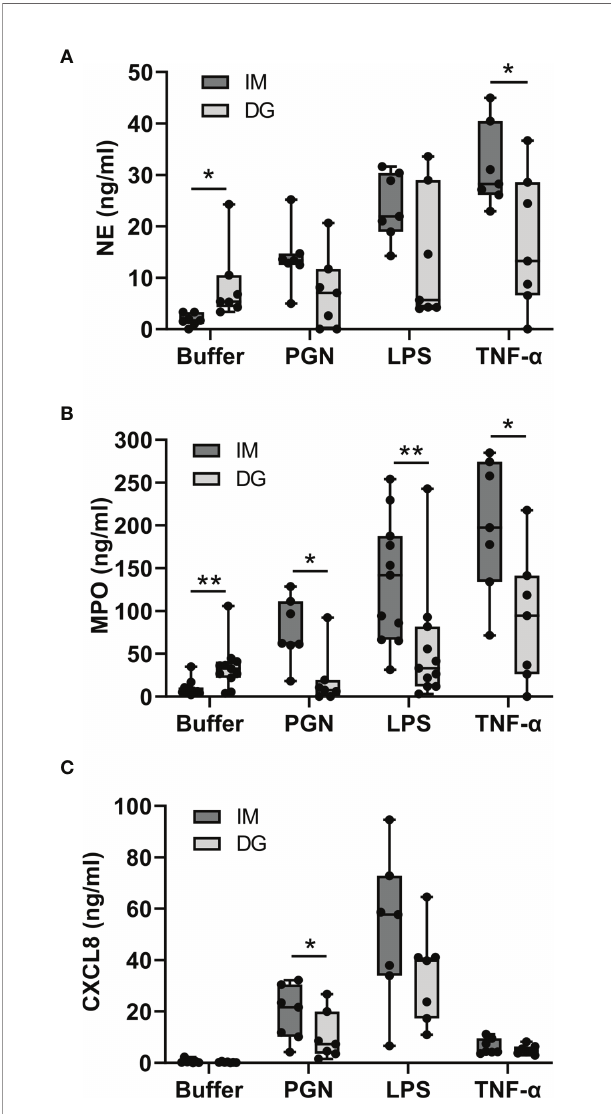
FIGURE 5 | Neutrophils puri fi ed by immunomagnetic isolation show less spontaneous but more stimulus-provoked degranulation, whereas CXCL8 is produced irrespective of the puri fi cation method. Peripheral blood neutrophils were isolated by immunomagnetic (IM) or density-gradient (DG) puri fi cation and stimulated for (A, B) 2 hours or (C) 24 hours with buffer, PGN (1 µg/ml), LPS (5 µg/ml) or TNF- a (10 ng/ml). Subsequently, the concentration of (A) neutrophil elastase (NE), (B) myeloperoxidase (MPO) and (C) CXCL8 in the cell culture supernatant was determined by ELISA. Data are shown as box- and-whisker plots (box: median with interquartile range, whiskers: full data distribution), with each dot representing an individual healthy donor (n = 7- 11). Statistical differences were determined by Wilcoxon matched-pairs signed rank test (*p < 0.05; **p < 0.01 for statistical differences between neutrophils puri fi ed with immunomagnetic or density gradient